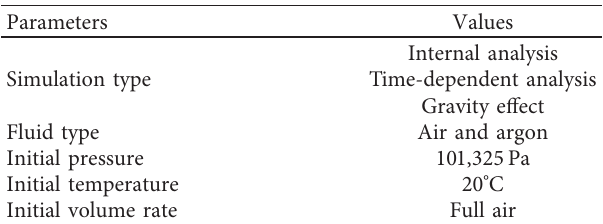
Table 3: Parameters for simulation.